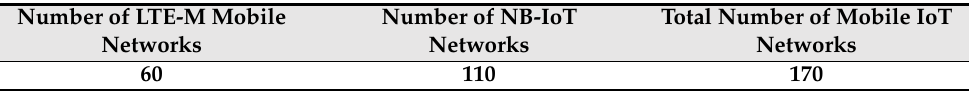
Table 2. Statistical dominance of commercial NB-IoT networks, last updated February 2022.